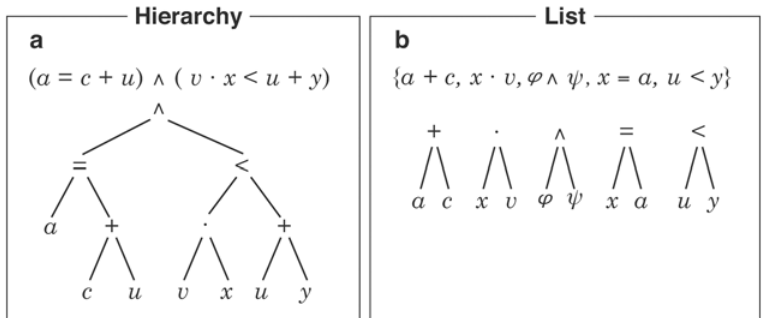
Figure 1. Illustration of the underlying binary tree structures for the various expressions used in the (a) hierarchical syntactic condition, and (b) list (non-hierarchical) condition. The grammatical/generative part of the syntax starts with an alphabet, out of which termini and formulae are (recursively) built, thereby yielding arbitrary hierarchical expressions. For assumed processing steps see (Supplemental Information: Figure